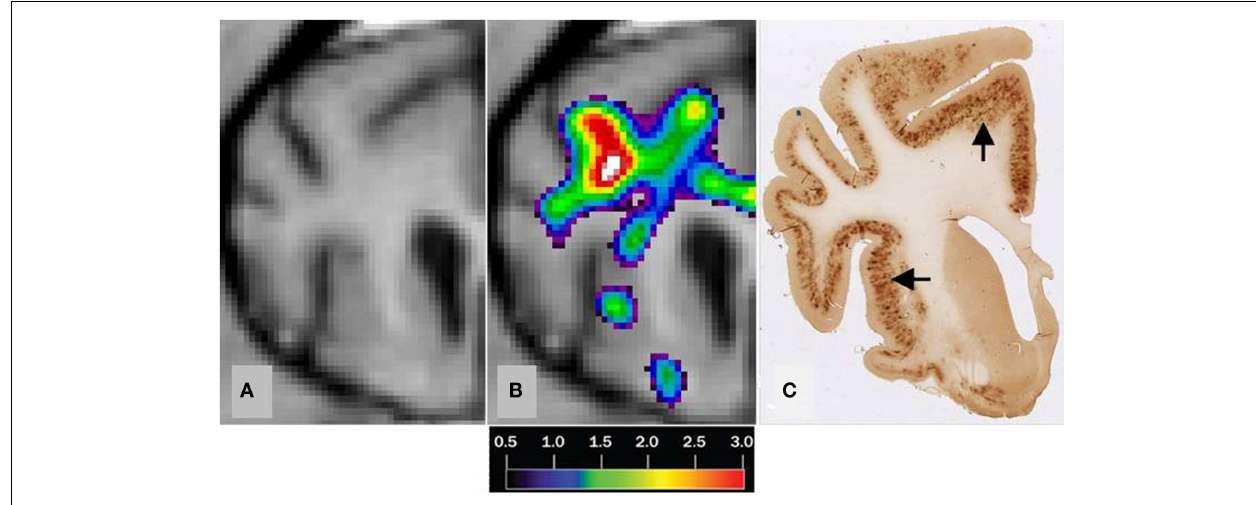
high retention and black indicating low retention. Calculated using the Hypotime method. (C) Corresponding section to 1 and 2 immunostained with amyloid (A β ) monoclonal antibody 6E10. Dark areas identifies positive areas of immunostaining using 6E10 indicating and thereby either A β and A β PP deposits or both (Marked with arrows). MRI, magnetic resonance imaging; PiB, Pittsburgh compound B; PET, positron emission tomography; CCD, canine cognitive